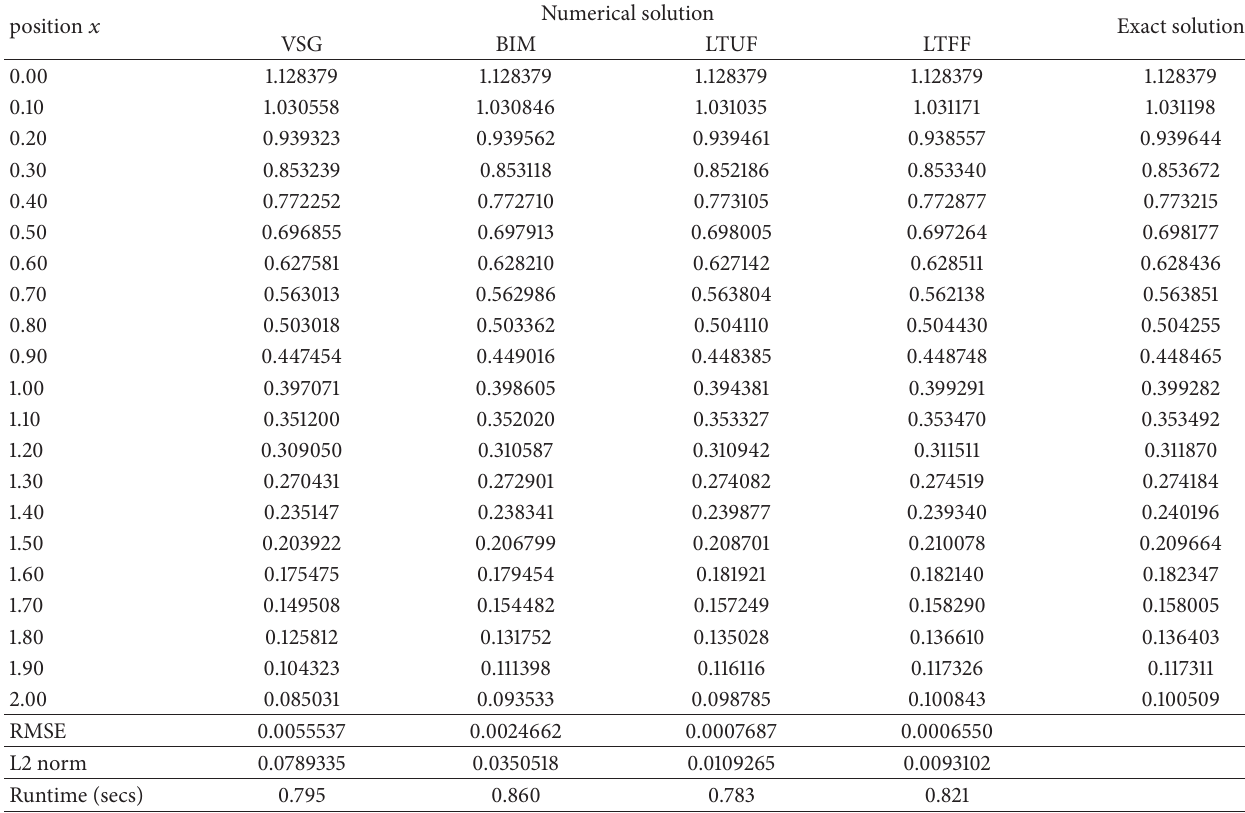
Table 7: Comparison of VSG, BIM, LTUF, LTFF method, and exact solution when 𝑓(𝑡) = 1